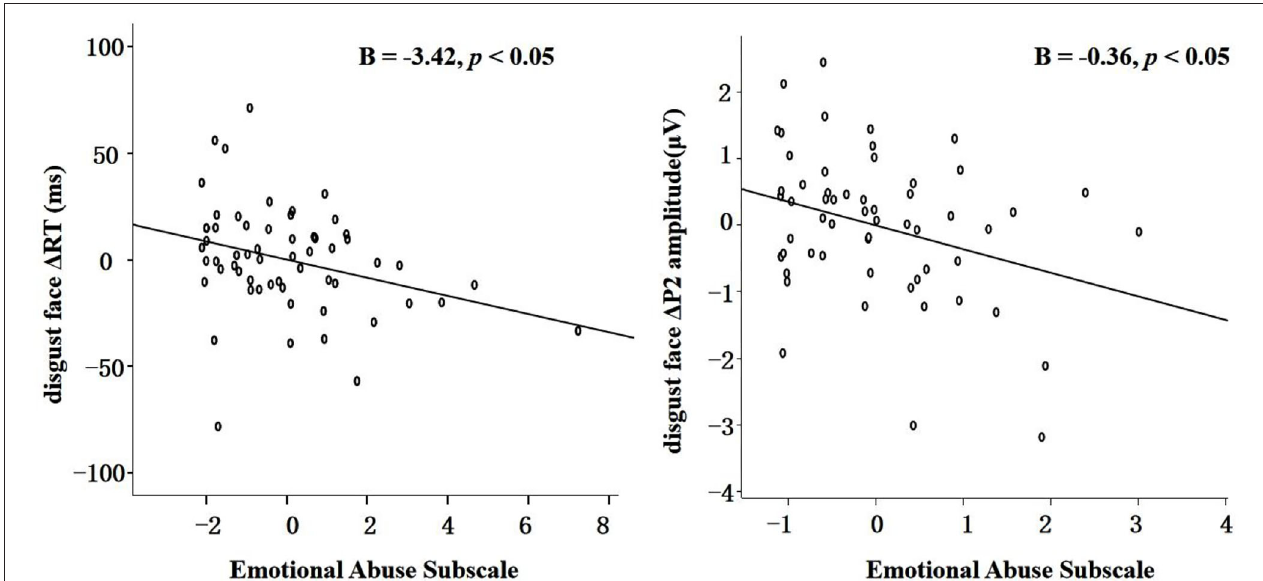
FIGURE 5 | Left: The partial correlation scatterplot of the relationship between emotional abuse score and the 1 RT for disgust faces (RT for disgust faces minus RT for neutral faces). Right: The partial correlation scatterplot of the relationship between emotional abuse score and the 1 P2 amplitude for disgust faces (the P2 amplitude for disgust faces minus the P2 amplitude for neutral faces).